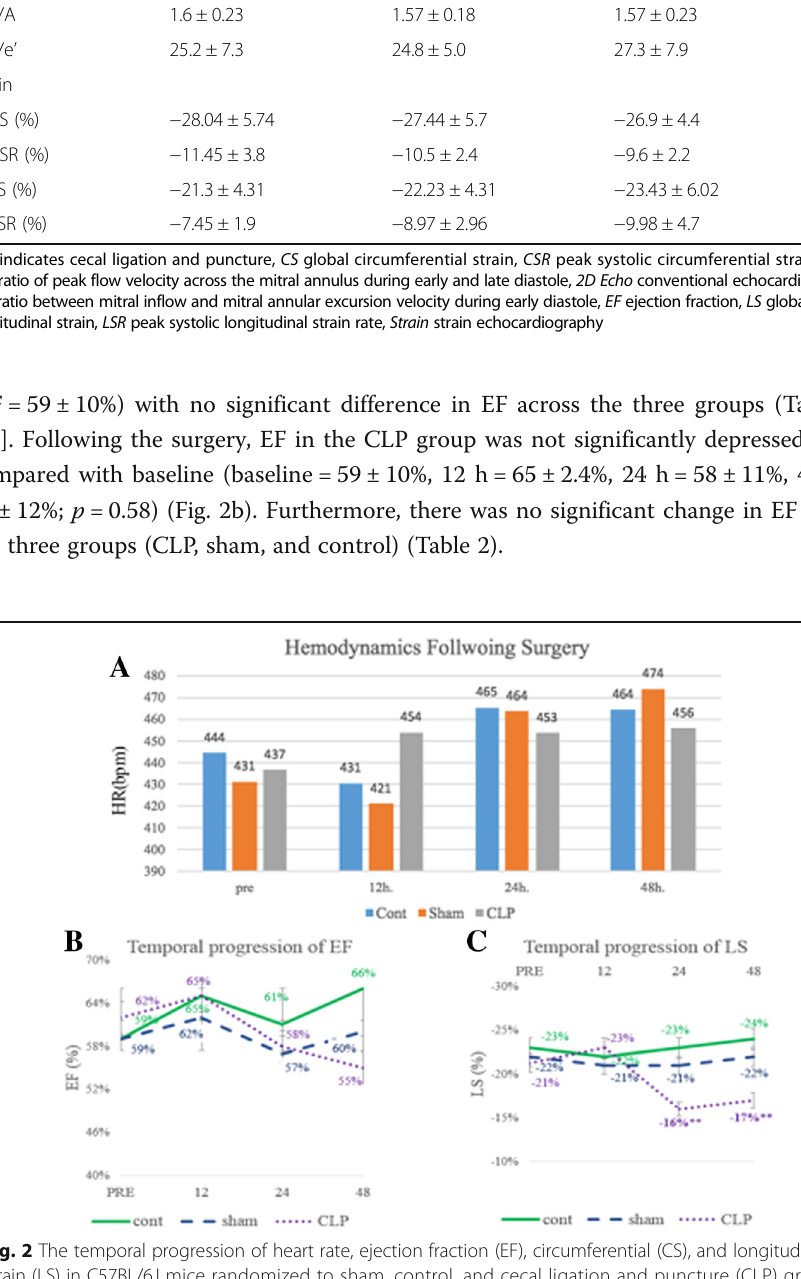
Fig. 2 The temporal progression of heart rate, ejection fraction (EF), circumferential (CS), and longitudinal strain (LS) in C57BL/6J mice randomized to sham, control, and cecal ligation and puncture (CLP) groups. a Demonstrates an overall increase in heart rate overtime with no significant difference between the three groups. b and c Demonstrate notable depression in longitudinal strain (LS) in the CLP group at 24 and 48 h without change in the